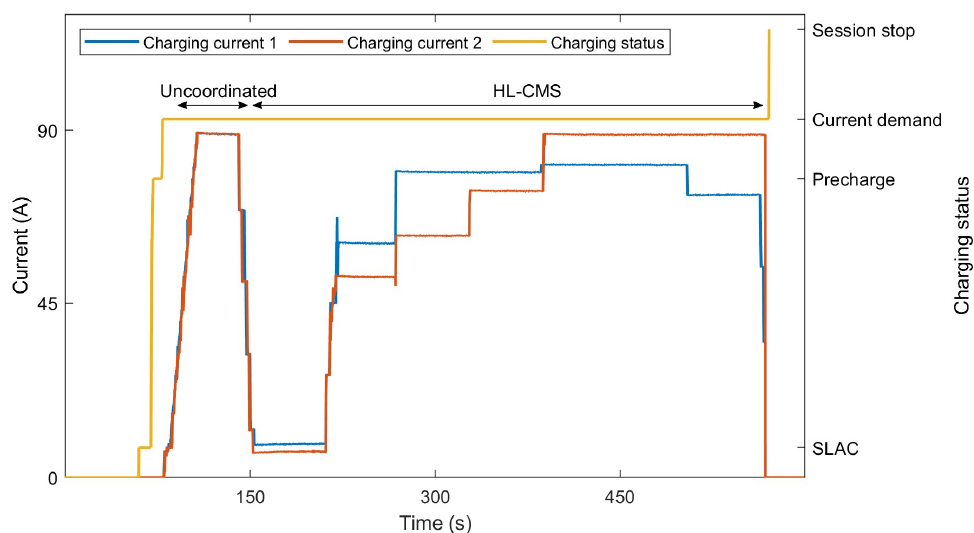
Figure 9. Experimental test results of the HL-CMS with the embedded RTSO algorithm.